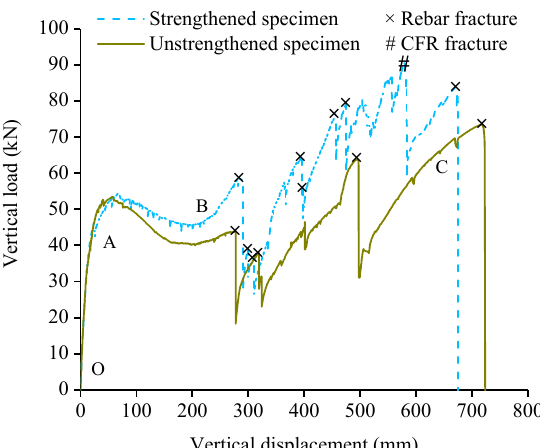
Figure 12. Vertical load-displacement curves of the strengthened and unstrengthened specimens. The OA segment is the FA stage. At this stage, CFR was not tightened and did not work, tension cracks appeared on the concrete surface of the tensile region of the strengthened